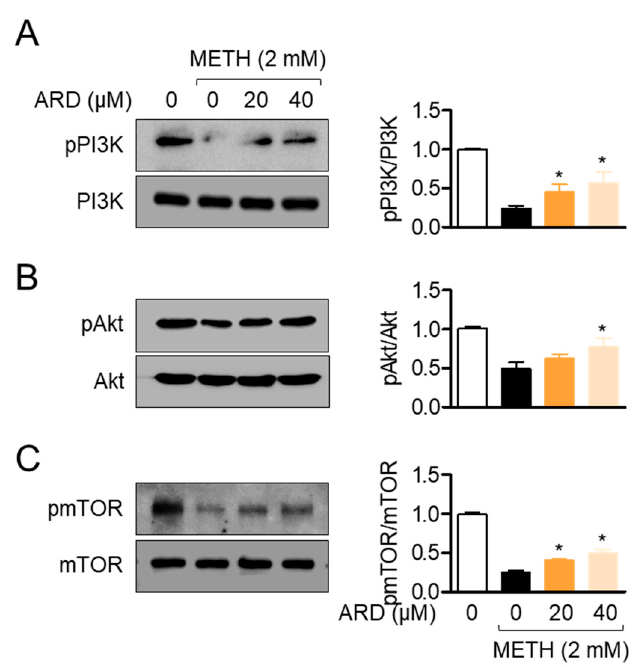
Figure 5. ( A – C ) SH-SY5y cells (1 × 10 5 /well, 6-well plate) were pre-treated with the indicated concentration (0 to 40 µ M) aromadendrin for 1 h and exposed to 2 mM METH for 30 min. Harvested cells were lysed for Western blotting analysis to detect the phosphorylation level of PI3K ( A ), Akt ( B ), and mTOR ( C ). The phosphorylation levels of indicated proteins were normalized with the level of total proteins indicated. The mean value of three experiments ± SEM is presented. * p < 0.05 between METH-treated cells.